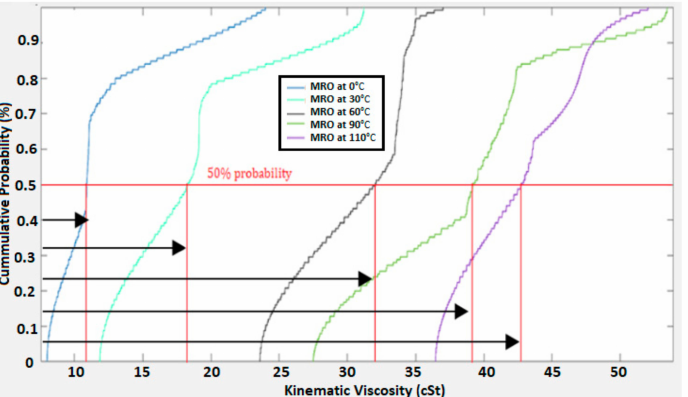
Figure 15. Cumulative probability density function of MRO showing variation of kinematic viscosity in different temperature level.